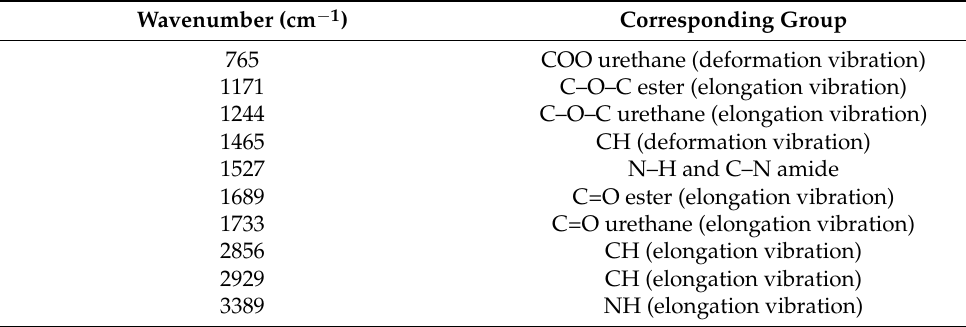
Figure 2. FT-IR spectrum of Bio 2K PU-1. Table 3. Overview of the functional groups in Bio 2K PU-1 detected by